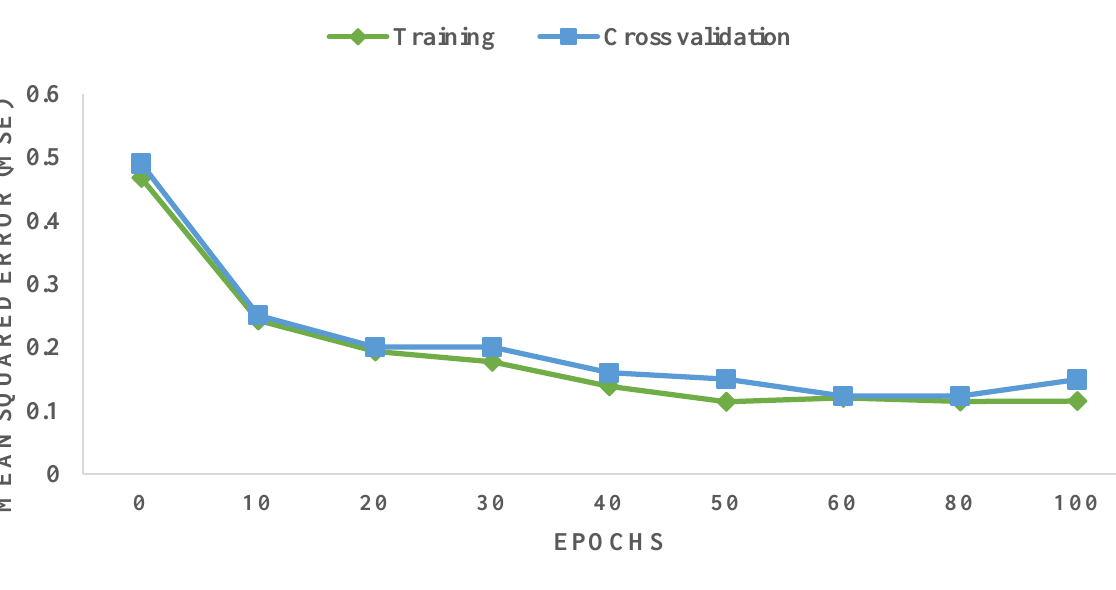
Figure 2. Convergence of the average MSE value during training and cross validation of ANN model.